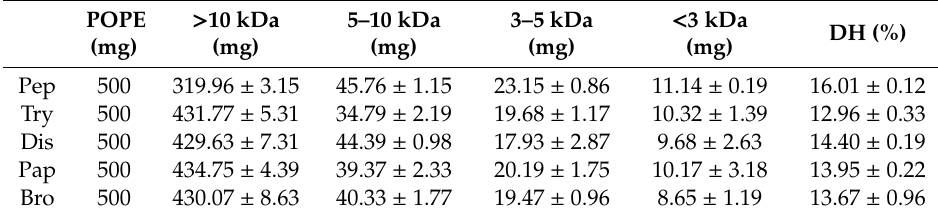
Table 1. Degree of Hydrolysis for POPE hydrolyzed by Pep, Pepsin-treated; Try, trypsin-treated; Dis, dispase-treated; Pap, papain-treated and Bro, bromelin-treated. The fractions (mw < 10 kDa) were designed as peptide, and the DH was calculated as DH = (weight of fraction (5–10 kDa) + weight of fraction(3–5 kDa) + weight of fraction ( < 3 kDa)) / weight of POPE. The values are presented as the mean ± SD.